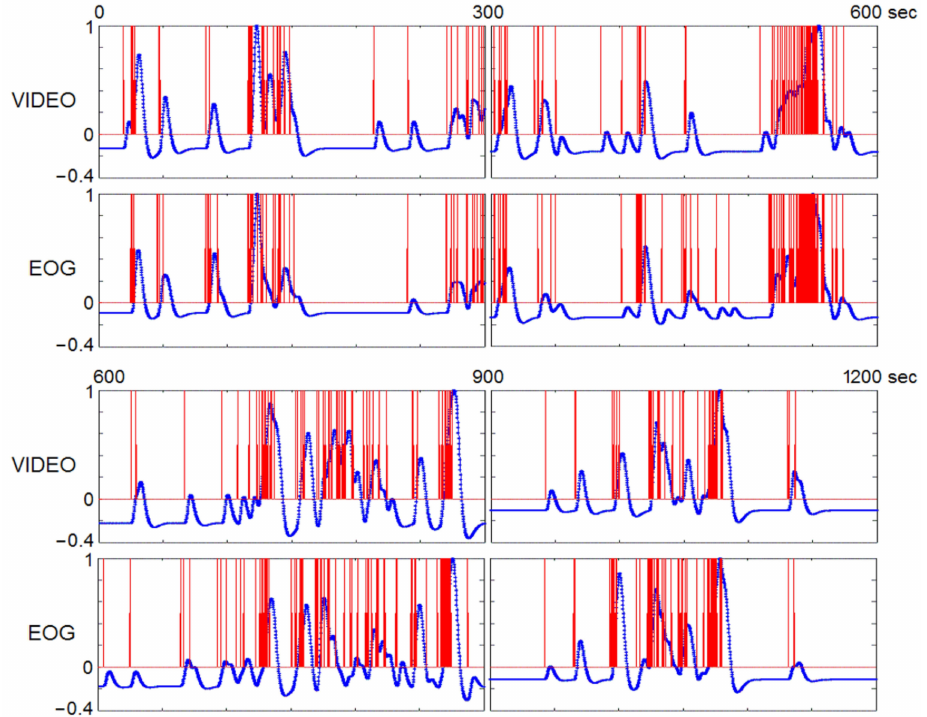
Figure 5. Timing of REMs using videorecording versus EOG. Eye movements were timed from videorecording and EOG that were obtained simultaneously in an out-of-magnet study (shown in red), then convolved with hemodynamic function (shown in blue). The hemodynamic impulse response had a six-second latency. There are five data points in one second. Regardless of the method of timing eye movements (videorecording, EOG, or other), the step right before correlation with fMRI data is to convolve with hemodynamic function. Therefore, these common end products (the curve derived from videorecording and the curve from EOG-recording, both shown in blue) were used in comparing video and EOG methods. The correlation between those two curves was highly significant ( r s = 0.84; p < 0.00005). Adapted from Hong et al. (2009) with the permission from